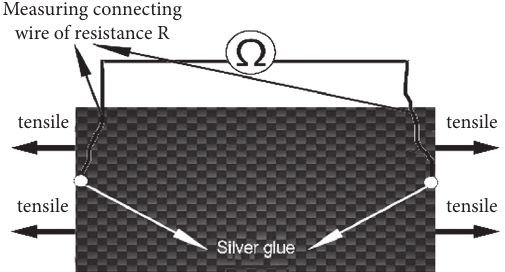
Figure 7: Schematic diagram of the longitudinal tensile test.